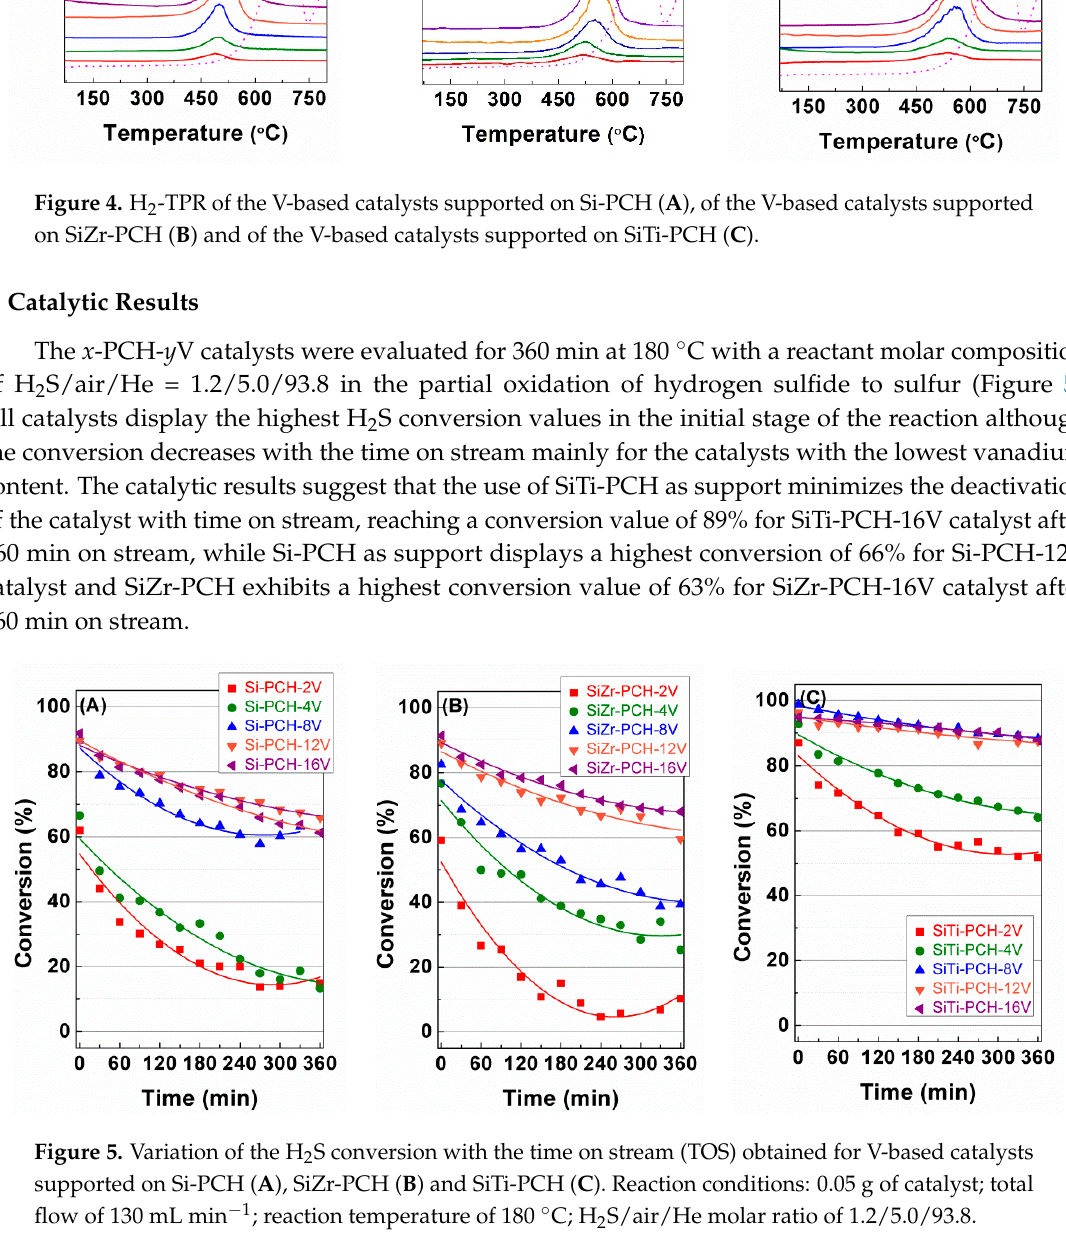
Figure 6. Variation of the sulfur yield with the time on stream (TOS) obtained for V-based catalysts supported on Si-PCH ( A ), SiZr-PCH ( B ) and SiTi-PCH ( C ). Reaction conditions: 0.05 g of catalyst; total flow of 130 mL min − 1 ; reaction temperature of 180 °C; H 2 S/air/He molar ratio of 1.2/5.0/93.8.